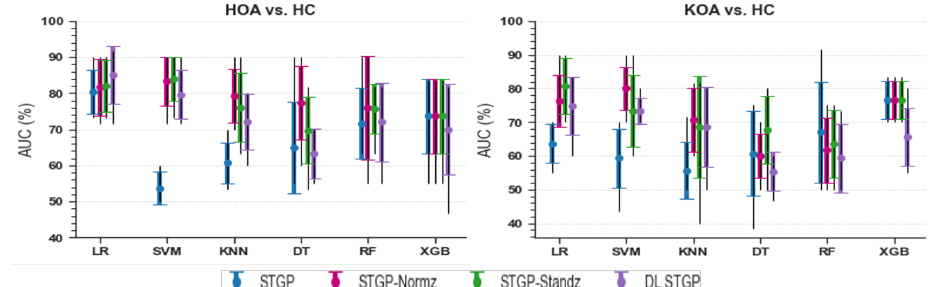
Figure 15. Baseline models AUC using raw STGP and scaled STGP